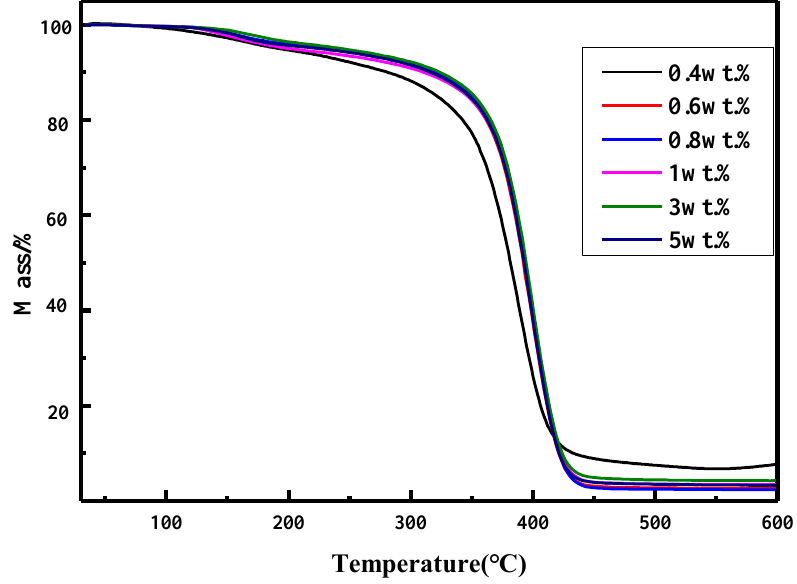
Figure 5. TGA curves for the coatings (entries 2–7 in Table 4).